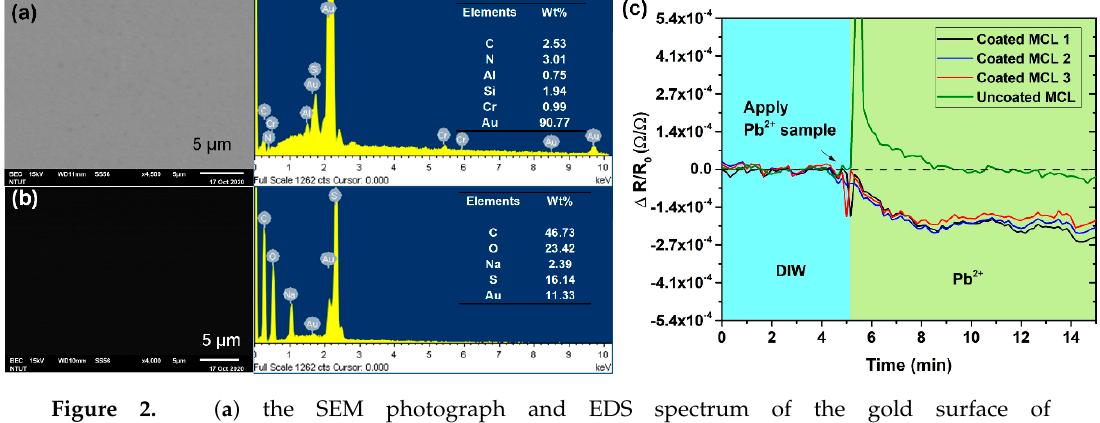
Figure 2. ( a ) the SEM photograph and EDS spectrum of the gold surface of microcantilever; ( b ) the SEM photograph and EDS spectrum measured from the poly (3,4-ethylenedioxythiophene):poly(styrenesulfonate) (PEDOT:PSS) coating film on the surface of microcantilever; and ( c ) response in resistance change as a function of time, for microcantilevers coated with and without the PEDOT:PSS sensing film on the gold surface after the injection of a 100 ppm Pb 2+ solution.